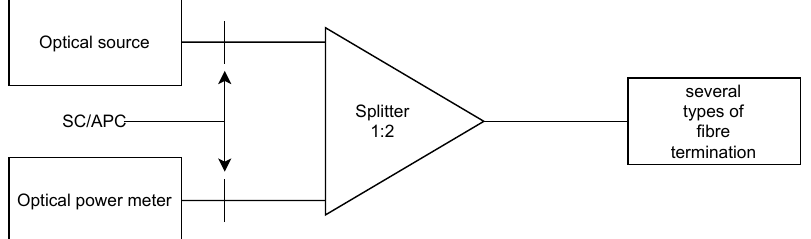
Figure 8. Scheme for back-reflection measurement.